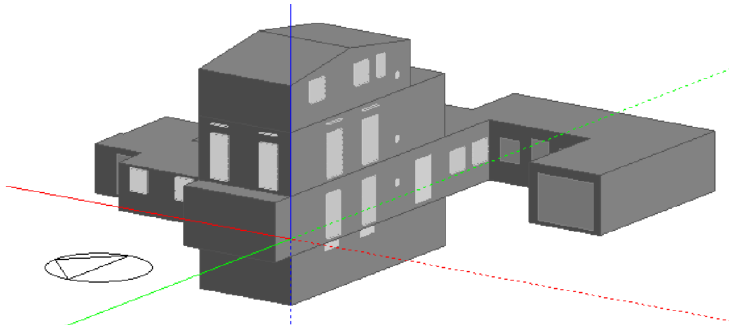
Figure 6. Rainfall for the city of Portici (near Naples, Southern Italy).